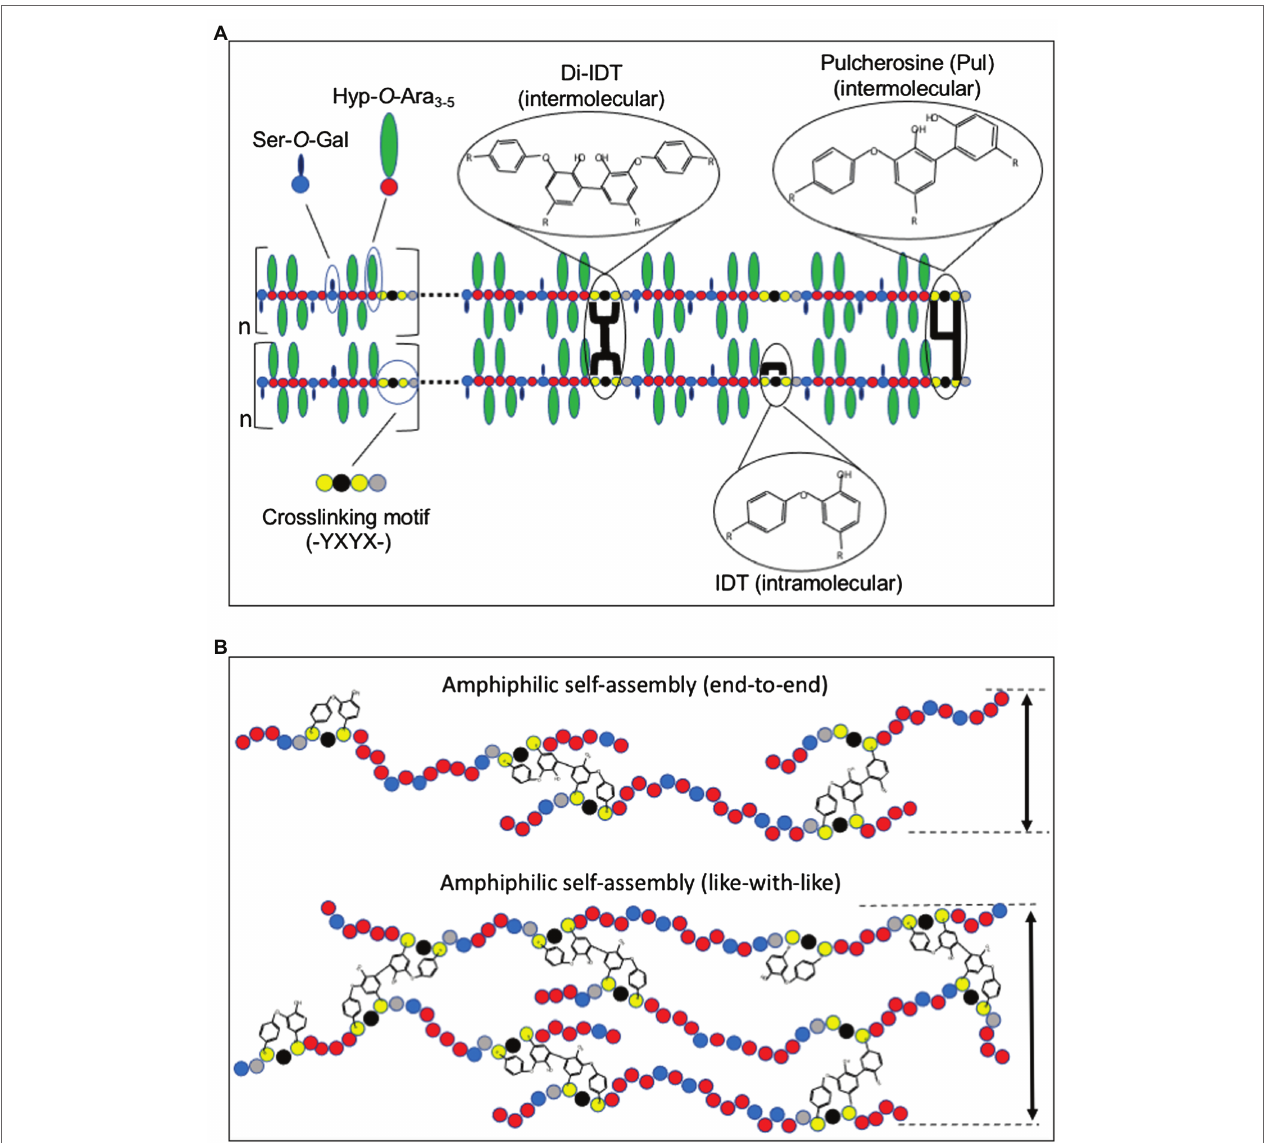
FIGURE 1 | Model for extensin (EXT) network assembly and crosslinking. (A) EXT precursors self-align through amphiphilic interactions between alternating hydrophilic Hyp-glycomodules (Hyp- O -Ara 3-5 and Ser- O -Gal) and hydrophobic crosslinking motifs (-Tyr-X-Tyr-X). Intermolecular crosslinks such as pulcherosine (Pul) and di-isodityrosine (di-IDT) and intramolecular crosslinks via isodityrosine (IDT) are indicated. Intermolecular crosslinks are catalyzed by extensin peroxidases (EPs) and result in insolubilization of EXT precursors in the cell wall. (B) Schematic presentation of “end-to-end” and “like-with-like” arrangements during amphiphilic self-assembly of EXTs (Cannon et al., 2008). While “end-to-end” arrangement may favor branching and network elongation, “like-with-like” self- assembly may contribute to the thickness of the EXT polymer. Amino acids are indicated as colored circles: Tyr (yellow), Hyp (red), galactosylated Ser (blue), and variable amino acids (X, black and